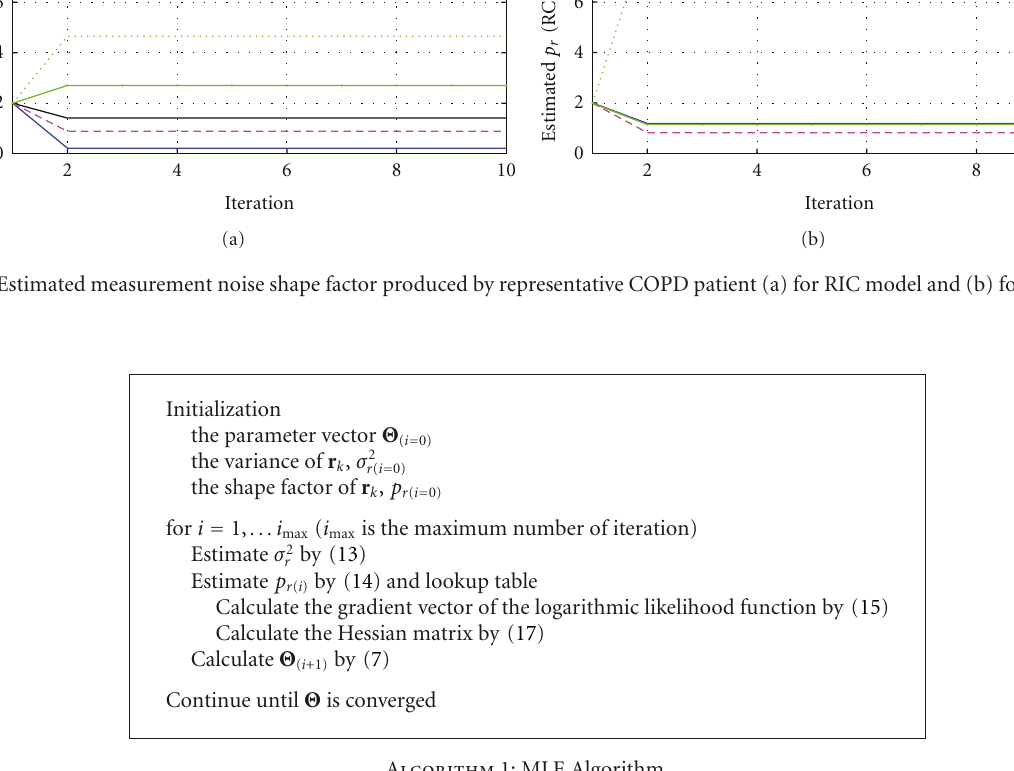
Algorithm 1: MLE Algorithm.